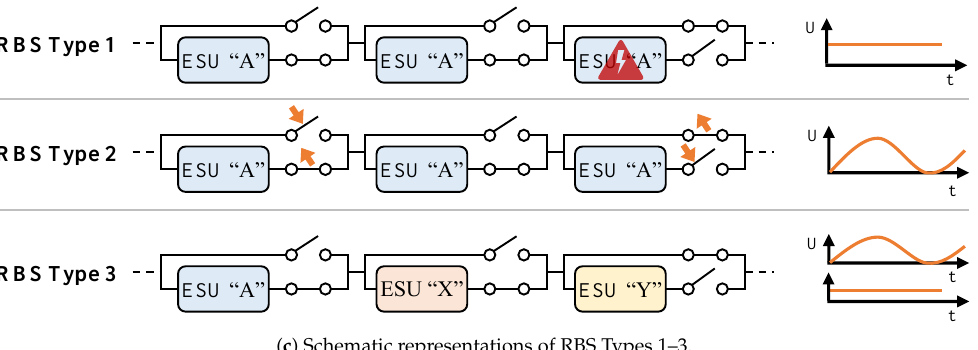
Figure 6. ( a ) Visualization of possible ESUs including single cells, multiple cells, and different cell types. ( b ) A serial connected RBS with half bridge microtopology and all possible switching states. ( c ) Schematic representation of RBS Types 1–3 with the respective output voltage